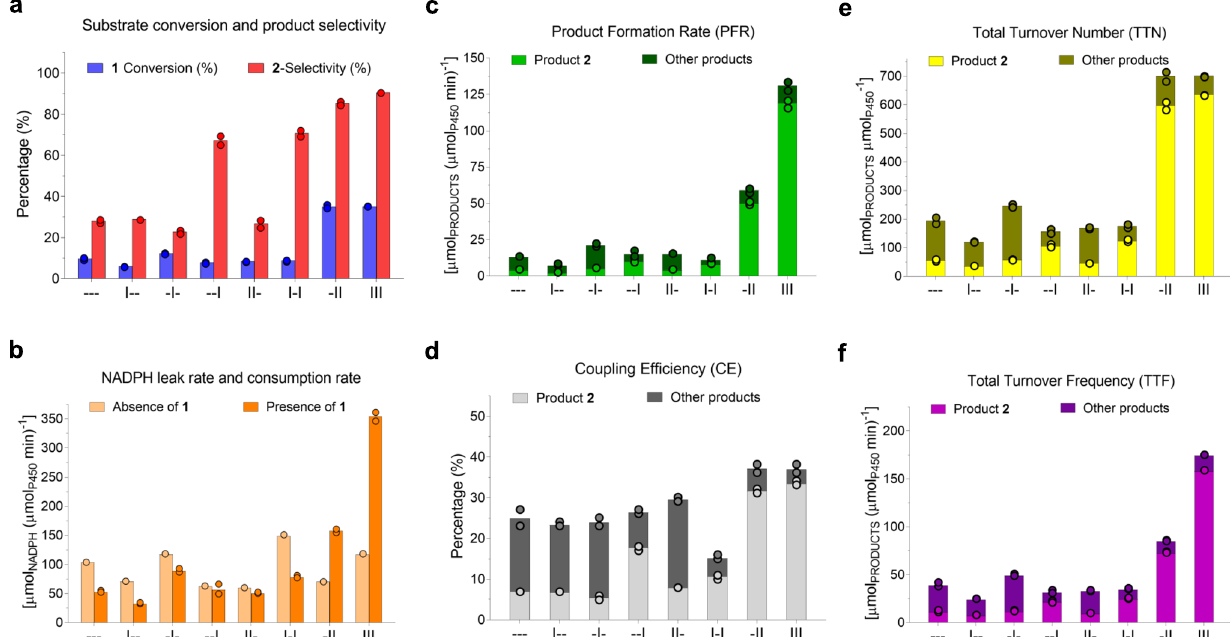
Fig. 2 Multiple enzymatic parameters of deconvolution mutants. a Selectivity and conversion data are obtained from HPLC data and shown in percentage. b NADPH leak and consumption rate were measured in the absence and presence of testosterone ( 1 ) substrate, respectively. c Product formation rate (PFR) is calculated by multiplying the NADPH consumption rate by coupling ef fi ciency. d Coupling ef fi ciency (CE) is the ratio between NADPH consumption and production formation, and it is reported in percentage. e TTN describes the total moles of products per moles of enzyme after NADPH depletion. f TTF normalizes TTN by time after NADPH depletion. See Fig. 1d for mutant abbreviations. Other products mainly include the 15 β -alcohol and